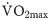
(A) Maximal oxygen uptake (V˙O2max), (B) maximum heart rate (HRmax), (C) maximum respiratory rate (RRmax), and (D) maximum expiratory minute volume (VEmax) at 24 hour before the first training (pre-training) and 24 hour after last training (post-training). Data are mean±SD. *P<0.05 (compared with pre-training); #P<0.05 (NPPV vs non-NPPV).